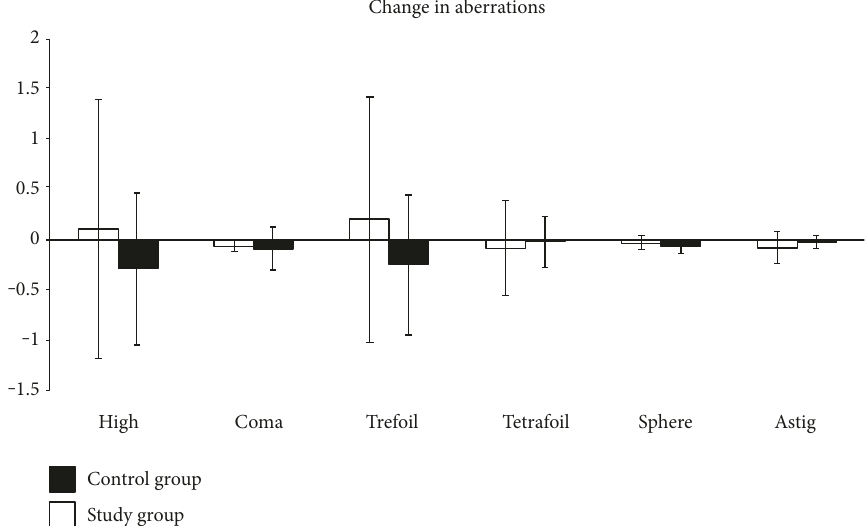
Figure 3: Changes in corneal topography from baseline to 3 months ( p > 0 05 ). It showed decreased high-order aberration in the study group but not in the control